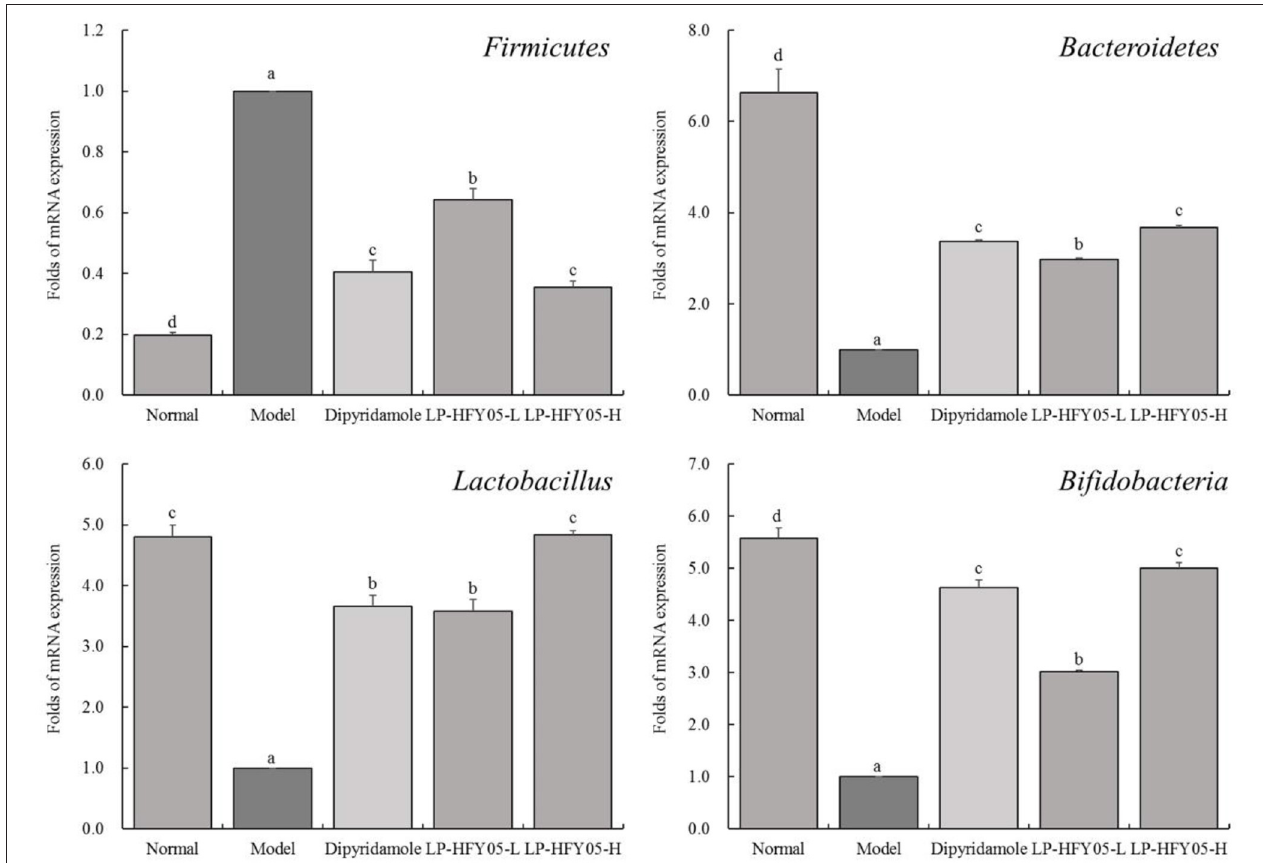
FIGURE 9 | The mRNA expression of Firmicutes , Bacteroidetes , Lactobacillus , and Bifidobacteria in mouse feces. a − d Mean values with different letters in the different bars are significantly different ( P < 0.05) according to SNK multiple-range test; Firmicutes , Bacteroidetes and Bifidobacteria : b, c and d are for significance vs model group; the same letter of c indicates that there is no significant difference ( P > 0.05) between the two groups; Lactobacillus : b and c are for significance vs model group; the same letter of b or c indicates that there is no significant difference ( P > 0.05) between the two